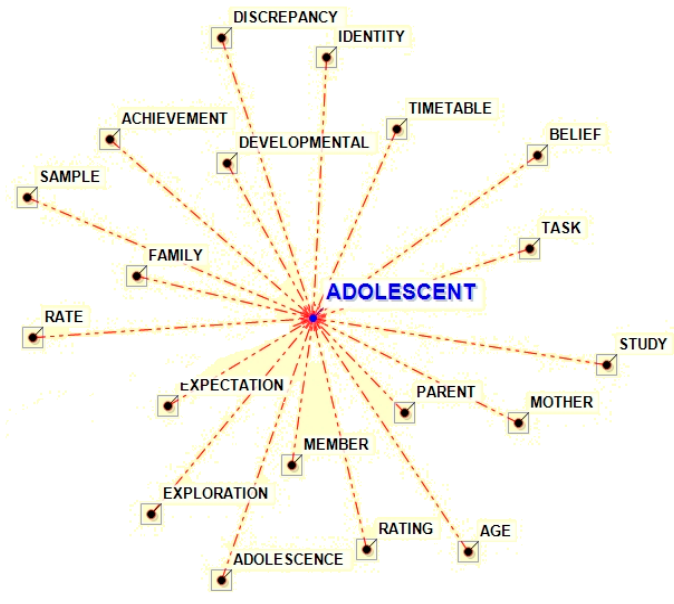
Figure 5. Radial diagram with “adolescent”.